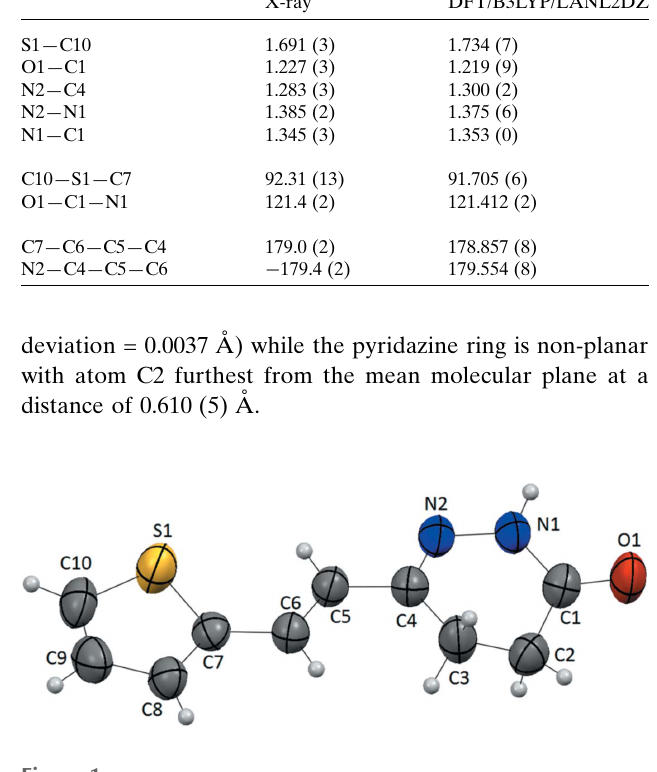
Figure 1 Molecular structure of the title compound showing the atom labelling and displacement ellipsoids drawn at the 50% probability level.